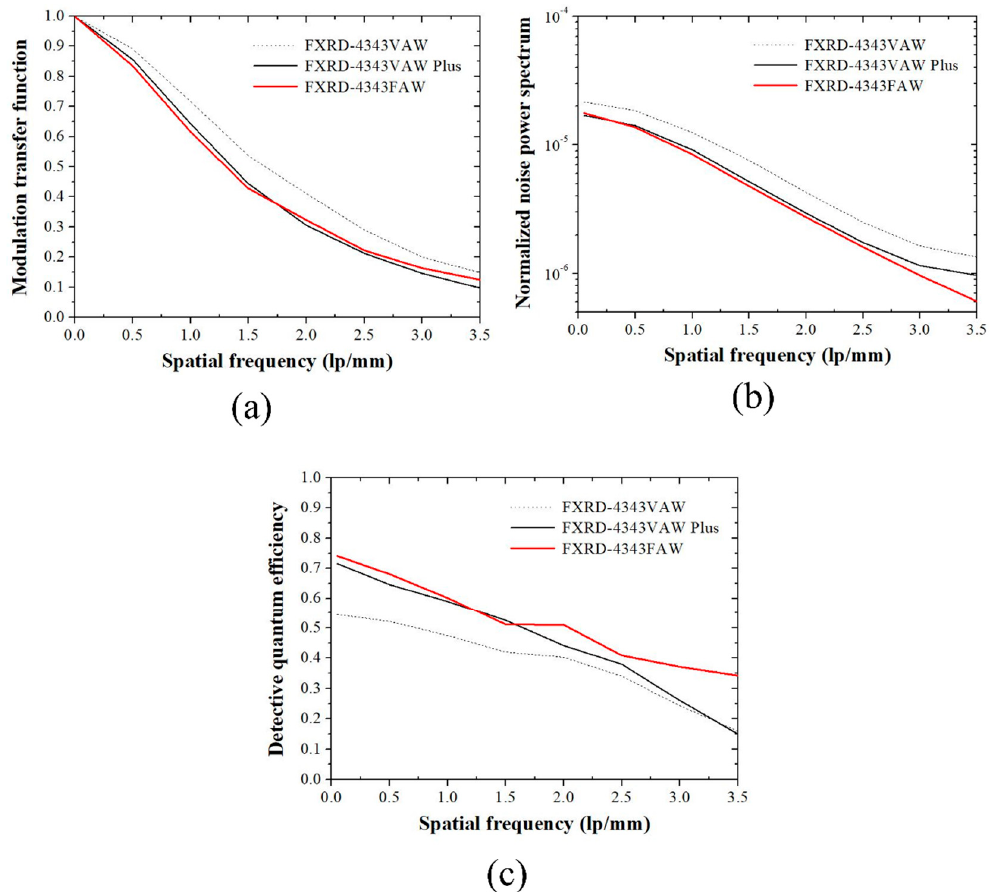
Figure 2. ( a ) MTF, ( b ) NNPS, and ( c ) DQE plots of the FXRD-4343VAW, FXRD-4343VAW Plus, and FXRD-4343FAW detectors according to IEC FXRD-4343FAW detectors according to IEC 62220-1-1:2015.